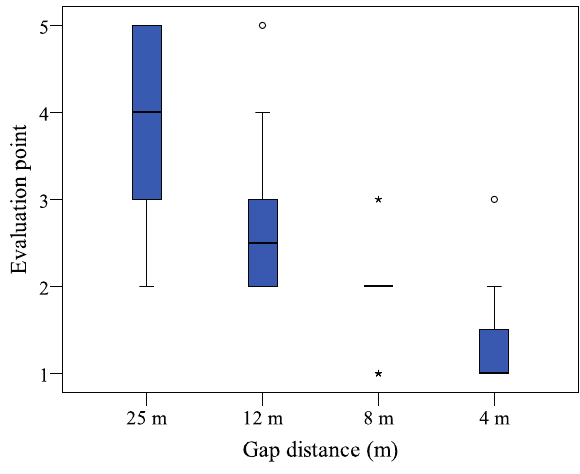
Figure 10. Subjective evaluation of ride comfort for the different driving